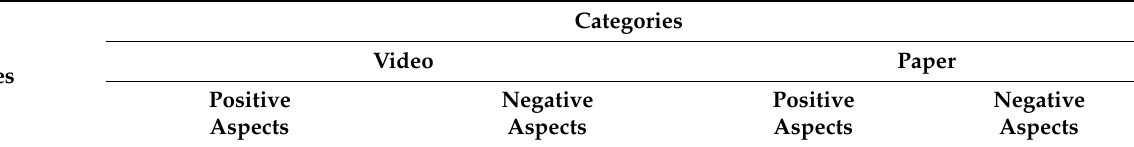
Table 2. Tree of themes and categories from the qualitative